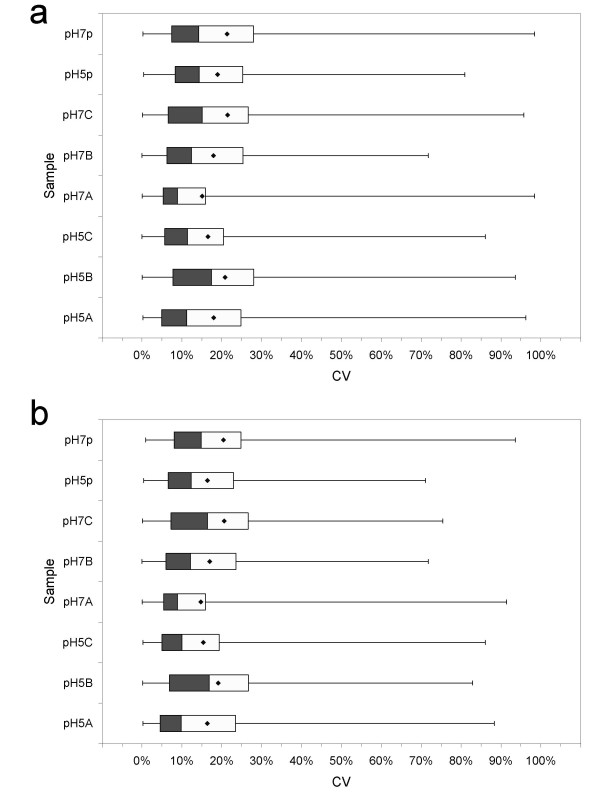
CV summary statistics. Boxplots displaying the summary statistics of the coefficient of variance (CV) of protein relative abundances for the pH5 culture triplicates (pH5A, pH5B, and pH5C), the pH7 culture triplicates (pH7A, pH7B, and pH7C), and the in silico pooled replicates (pH5p and pH7p). A boxplot summarizes the minimum, 25 percentile, 50 percentile, 75 percentile, and maximum CV's of a sample. a) Boxplots are plotted for the 174 proteins quantified between pH5p and pH7p. These 174 proteins include all those proteins quantified in pH5A(159), pH5B(159), pH5C(161), pH7A(131), pH7B(124), and pH7C(134). The numbers in parenthesis indicate the number of protein in a sample. b) Boxplots are plotted for the 121 proteins quantified in at least 5 of the 6 replicates of the pH5 and pH7 culture samples. The diamond dots indicate the mean CV's.